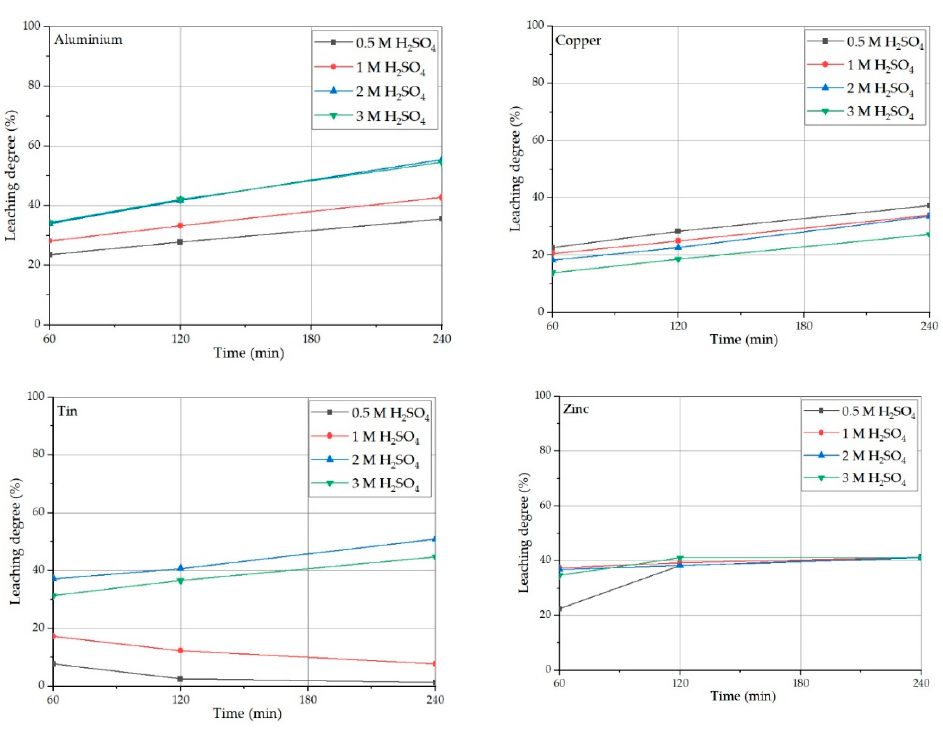
Figure 4. Influence of sulfuric acid concentration on leaching for a S/L ratio of 0.025 (30 g of PPCB).